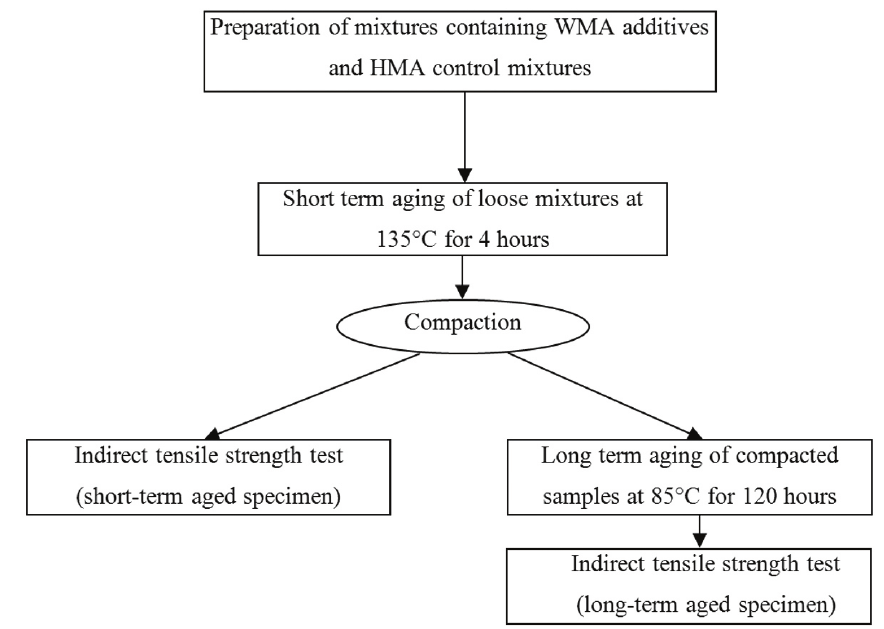
Figure 2. Short- and long-term conditioning